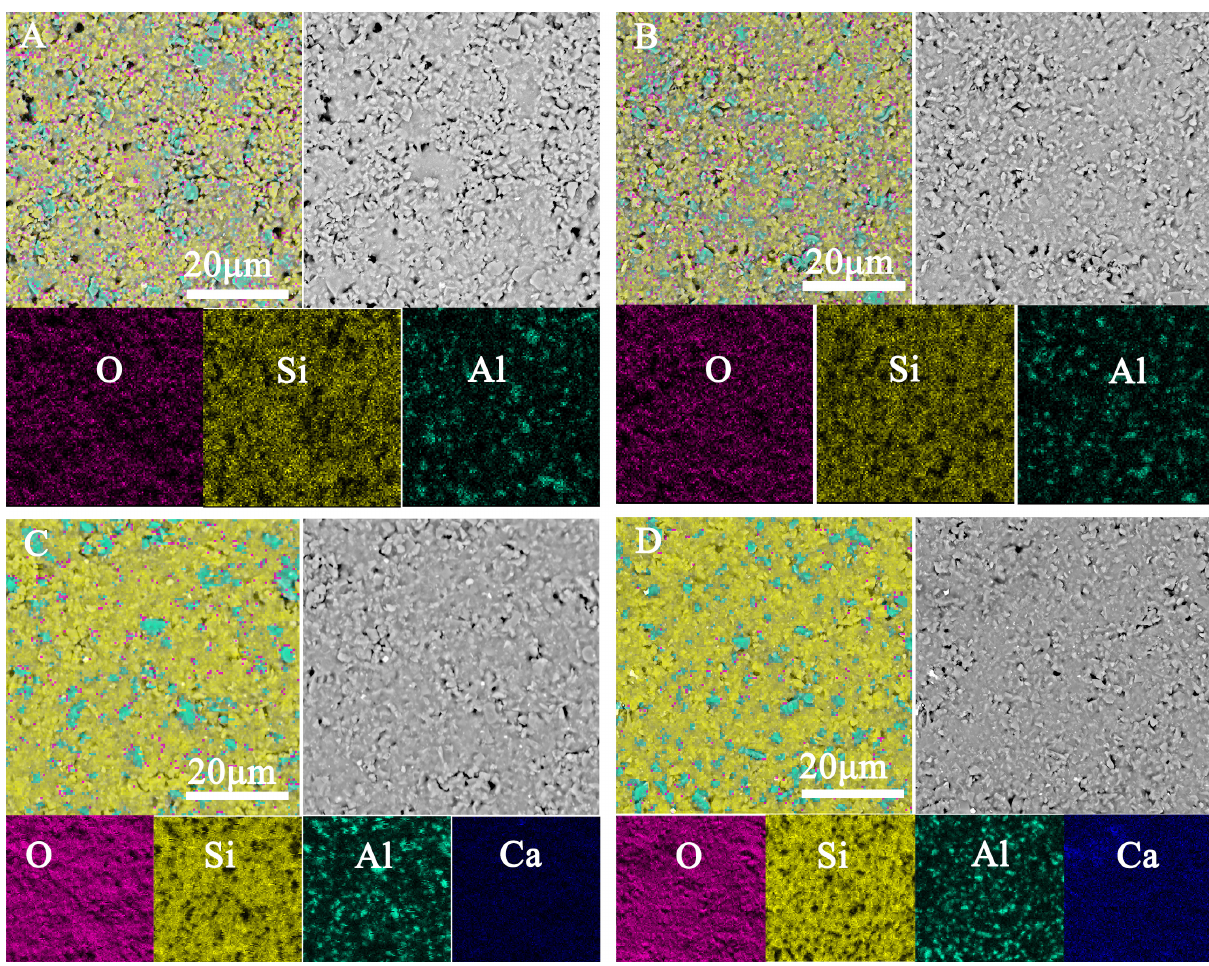
Figure 4: Elemental map distributions measured by back scattered electron mode: A) S1; B) S4; C) S8; D)